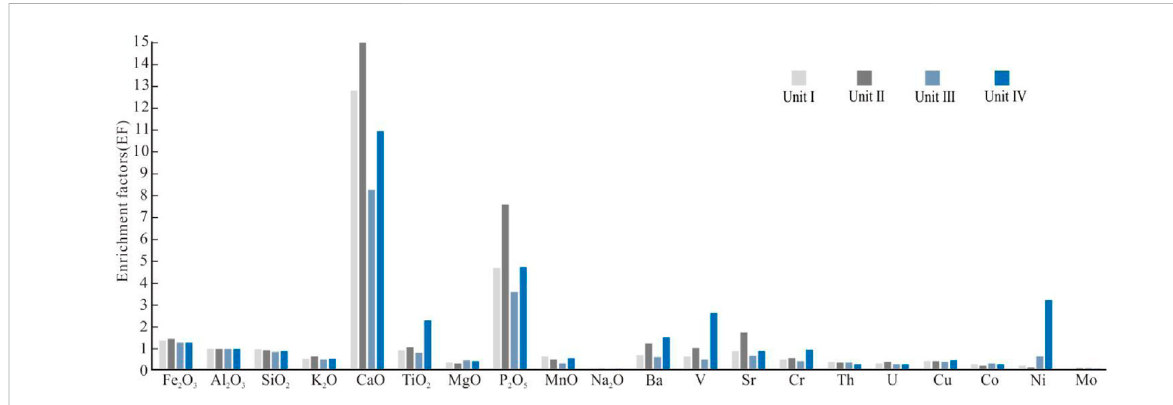
FIGURE 6 Enrichment coef fi cient of major elements in the Da ’ anzhai member of well C.